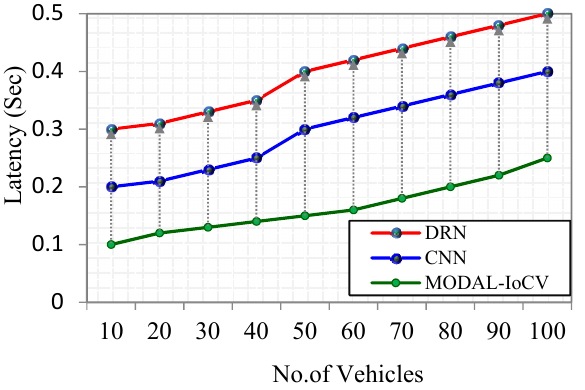
Figure 11. Number of vehicles vs. latency.